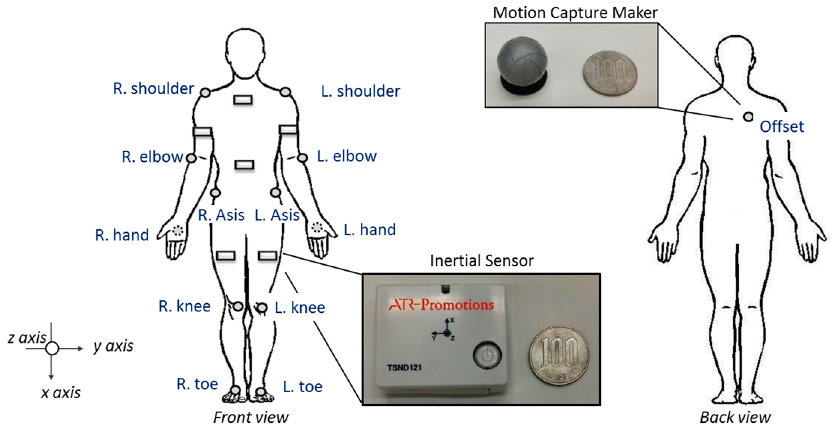
Figure 3. Installation of inertial sensors and motion capture markers on the patient.